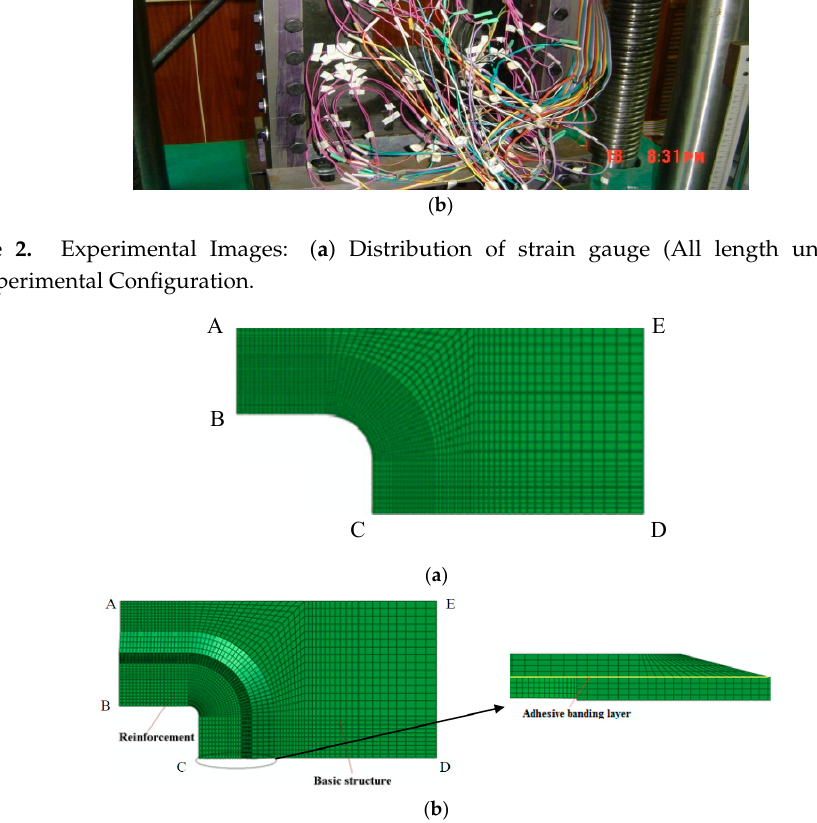
Figure 3. The FEM model: ( a ) unreinforced structure; ( b ) reinforced structure.